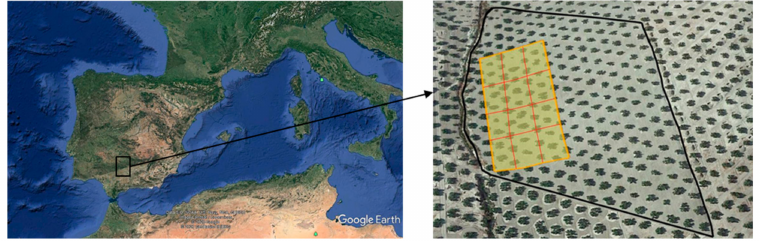
Figure 1. Study area. Garc í ez-Torredelcampo (Ja é n-Spain)—(37 ◦ 50 (cid:48) 20” N—3 ◦ 52 (cid:48) 32” W).